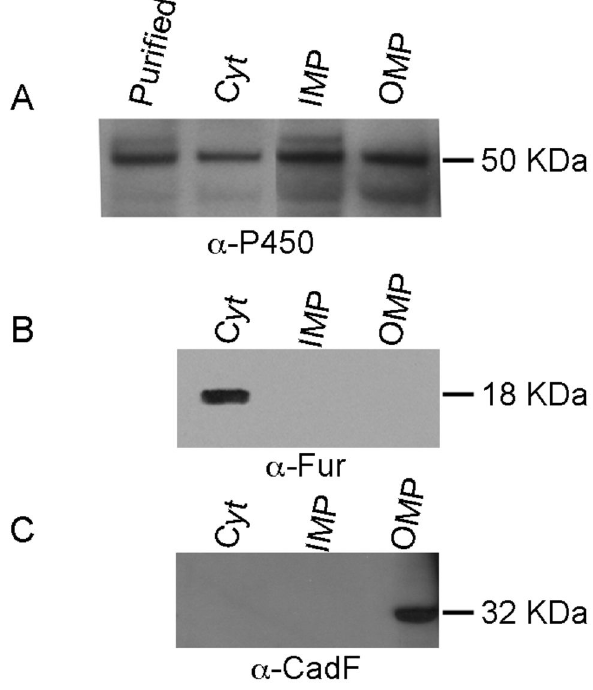
Figure 4. CYP1411c cellular localization. (A) Anti-P450 immunoblotting on bacterial fractions (cytosolic fraction, Cyt; inner membrane protein, IMP and outer membrane protein fraction, OMP). Recombinant CYP1411c protein (purified) was used as a positive control. Fractions were validated with an antibody recognizing the cytosolic Fur protein (B) and the outer membrane protein CadF (C).